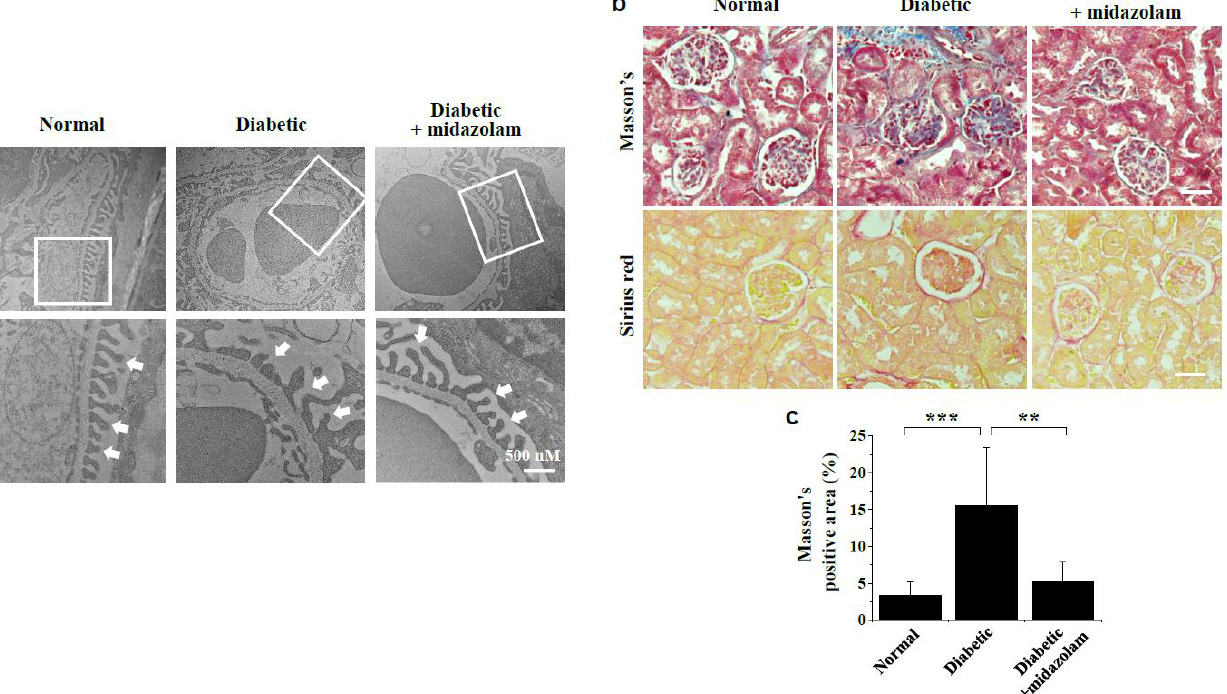
Figure 7. Midazolam treatment inhibits hyperglycemia-induced pathological alterations of glomerular ultrastructure and renal fibrosis in kidneys of diabetic mice. Glomerular ultrastructure was evaluated by transmission electron microscopy (TEM) analysis ( a ), and renal fibrosis ( b , c ) was assessed by Masson’s trichrome and Sirius red staining of kidneys from normal, diabetic, and midazolam-treated diabetic mice. ( a ): Representative micrographs of glomerular ultrastructure. The bottom micrographs display the magnified image of the square in the top images and show ultrastructural alterations in podocyte foot processes in the renal glomerulus of diabetic mice (indicated by arrows). Scale bar, 500 nm. ( b ) : Representative images of renal tissues stained with Masson’s trichrome and Sirius red. Scale bar, 50 μ m. ( c ): Quantification of areas positive for Masson ’ s trichome staining ( n = 8). ** p < 0.01, *** p < 0.001.